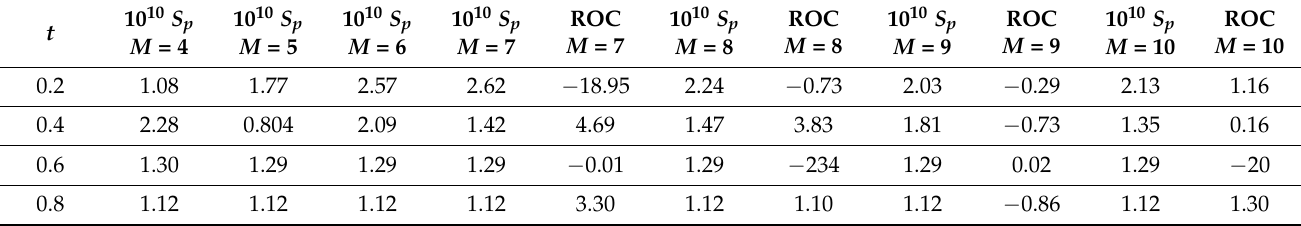
Table 2. The values of 10 10 S p and rate of convergence (ROC) at different points for k = 2 and various values of M by Bernoulli wavelets.